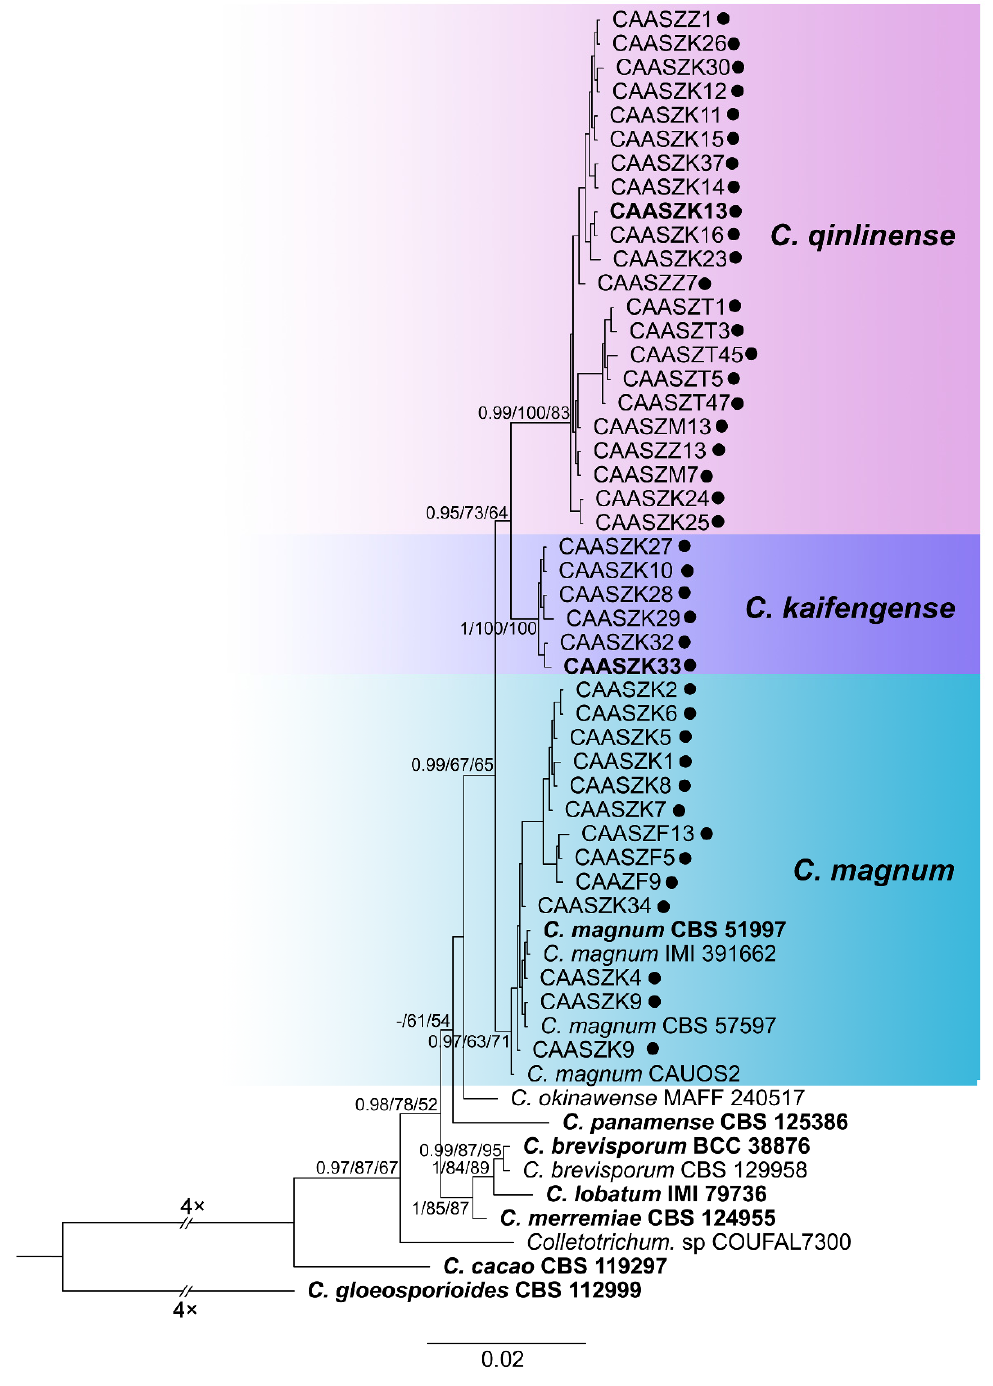
Figure 6. A Bayesian inference phylogenetic tree of 52 isolates in the C. magnum species complex. The species C. gloeosporioides (CBS 112999) was selected as an outgroup. The tree was built using concatenated sequences of the ITS, gadph , chs-1 , his3 , act , and tub2 genes. Bayesian posterior proba- bility (PP ≥ 0.90), MP bootstrap support values (MP ≥ 60%), and iqtree bootstrap support values (ML ≥ 50%) were shown at the nodes (PP/MP/ML). Ex-type isolates are in bold. Colored blocks indicate clades containing isolates from Citrullus lanatus in this study; circles indicate strains isolated from fruits. The scale bar indicates 0.02 expected changes per site.